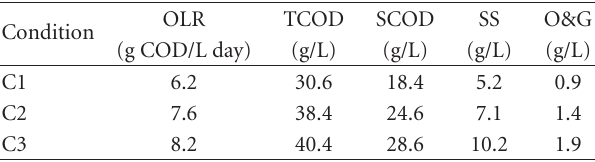
Values are averages of three determinations with standard deviations lower than 5% between